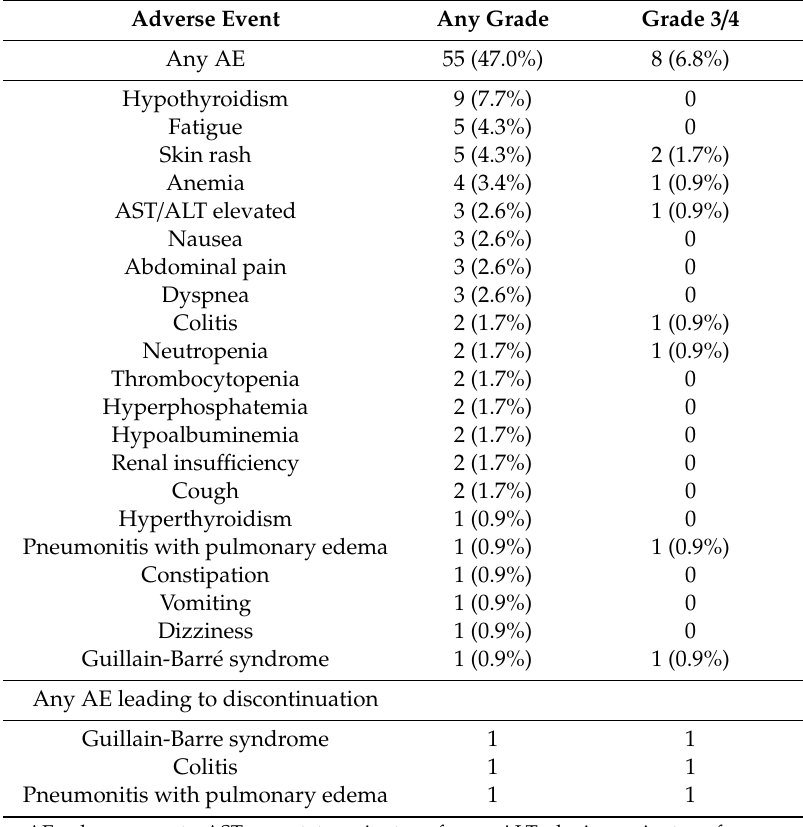
Table 3. Treatment-related adverse events in the total population ( n = 117). Adverse Event Any Grade